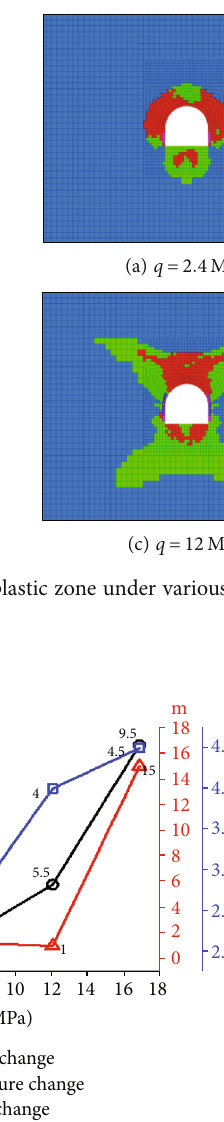
Figure 5: The damage depth of the surrounding rocks corresponding to the deviatoric